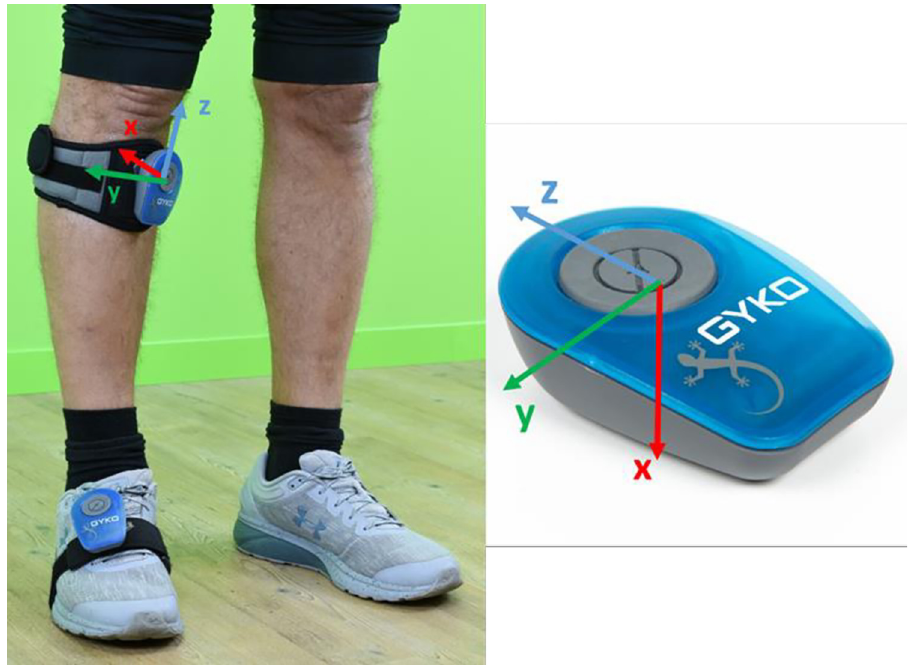
Fig 1. MIMU placement: ad hoc straps and tape were used to fix MIMUs on the foot and tibia.